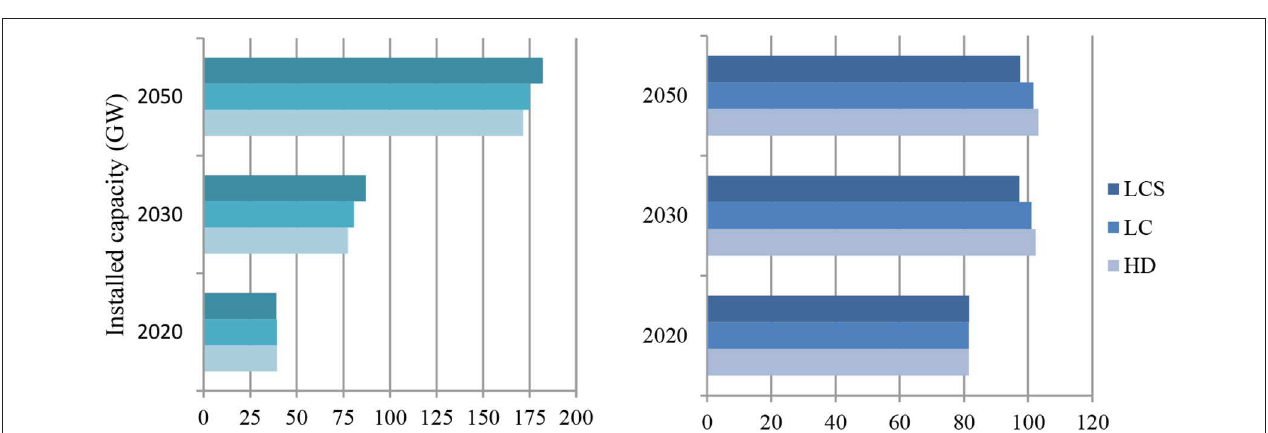
FIGURE 5 | The generation capacity of clean energy and coal in HD, LC, and LCS scenarios.